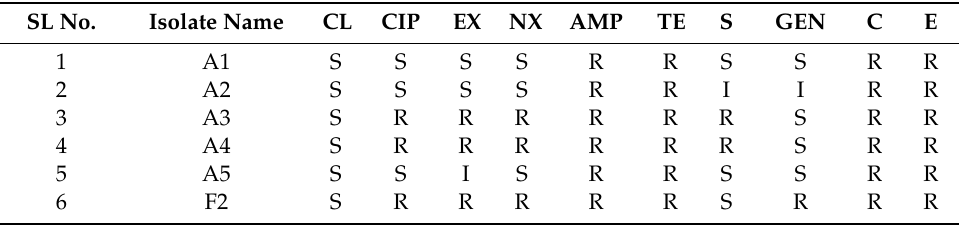
Table 4. Overall results of antibiotic sensitivity tests of APEC